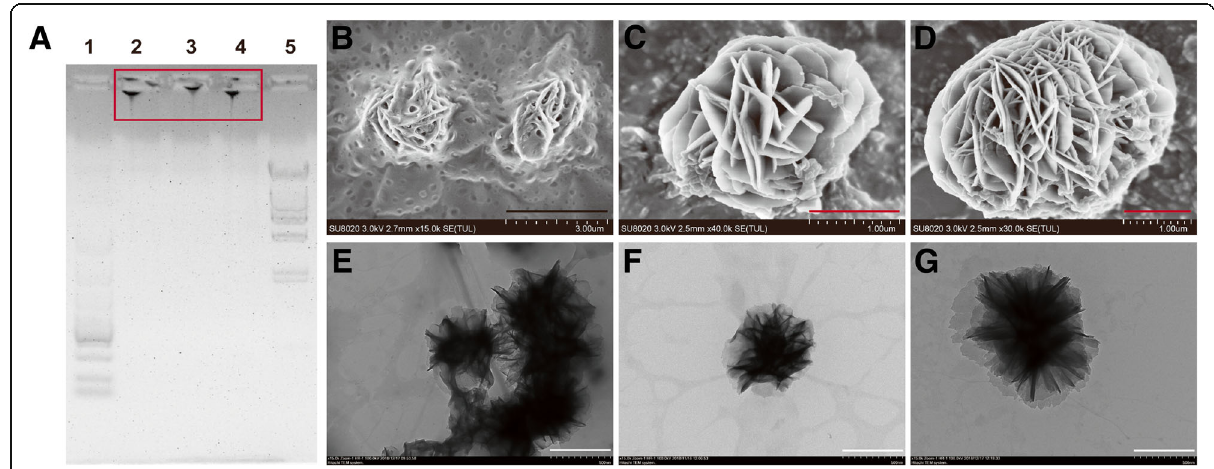
Fig. 1 The images of CpG-MCA gels and CpG-RCA gel. a Agarose gel electrophoresis image of CpG-RCA gel (R12) and CpG-MCA gels (R4M4 and R4M8). Lane 1, DNA MW standard marker λ -Hind III digest; lane 2, R12; lane 3, R4M4; lane 4, R4M8, lane 5, DL5000 DNA marker. SEM images of R12 ( b ), R4M4 ( c ), and R4M8 ( d ). TEM images of R12 ( e ), R4M4 ( f ), and R4M8 ( g ). Black scale bar is 3 μ m; red scale bar is 1 μ m; white scale bar is